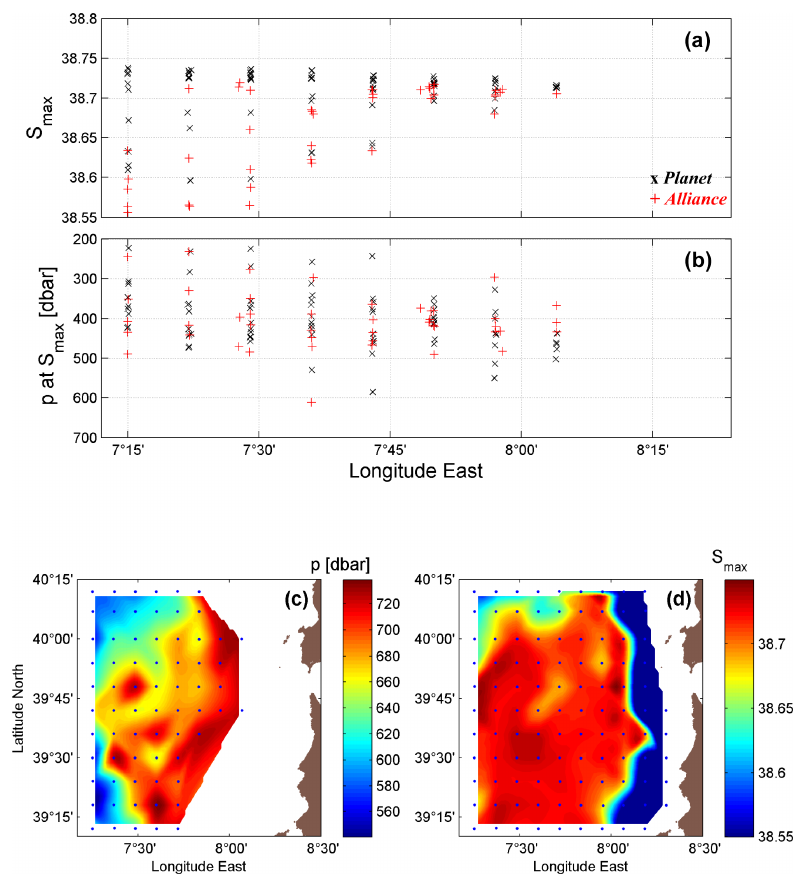
Figure 9. Characteristics of LIW, (a) salinity maximum ( S max ) of at least 400dbar deep CTD casts of Planet (x) and Alliance (+), (b) cor- responding pressure level of S max , (c) pressure level of lower boundary of LIW ( σ (cid:50) = 29 . 1kgm − 3 ) based on Planet CTD casts (blue dots), and (d) maximum salinity ( S max ) > 38.55 based on Planet CTD casts (blue dots).